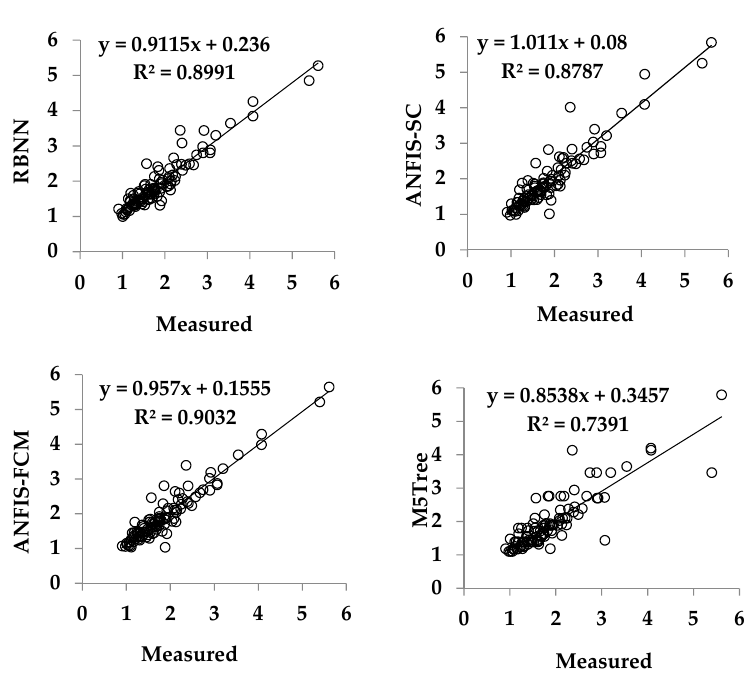
Figure 4. Strength estimates of the RBNN, ANFIS-SC, ANFIS-FCM and M5Tree models Figure 6. Strain estimates of the RBNN, ANFIS-SC, ANFIS-FCM and M5Tree models (dimensionless: ′ ′ / co f ). (dimensionless: cc f ε cc / ε co ).